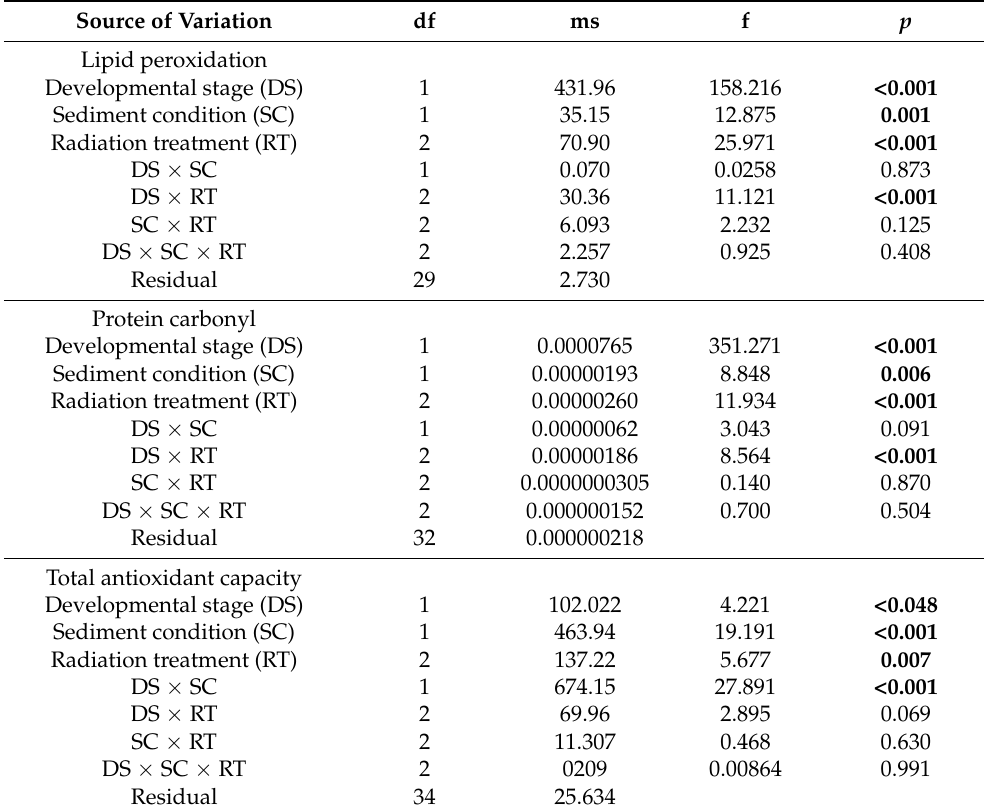
Table 2. Three-way ANOVA for the estimation of oxidative response (protein carbonyl and lipid per- oxidation) and antioxidant capacity in adults and juveniles of the anemone A. hermaphroditica exposed to different levels of experimental radiation P (PAR), PA (PAR + UVA) and PAB (PAR + UVA + UVB) with and without sediment. Bold numbers indicate significant difference ( p <